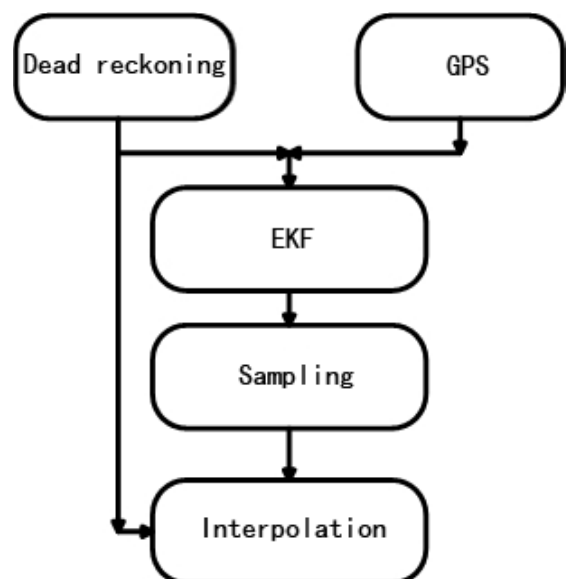
Fig.3. Flow of offline interpolation algorithm.